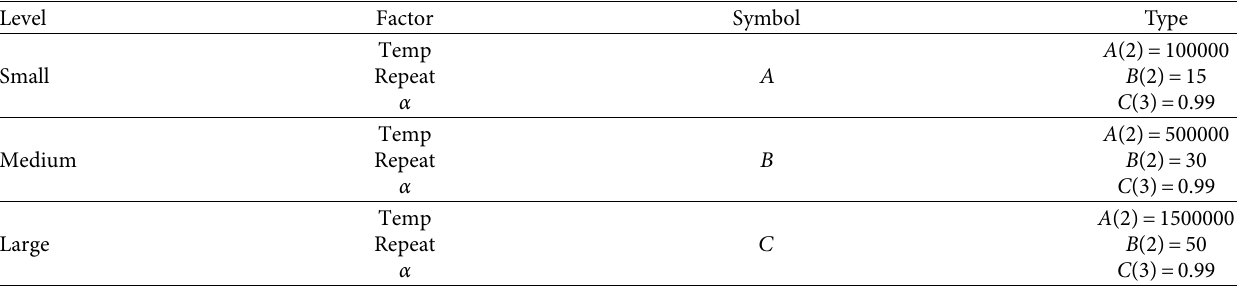
Table 7: Operators, parameters, and their levels (SA).